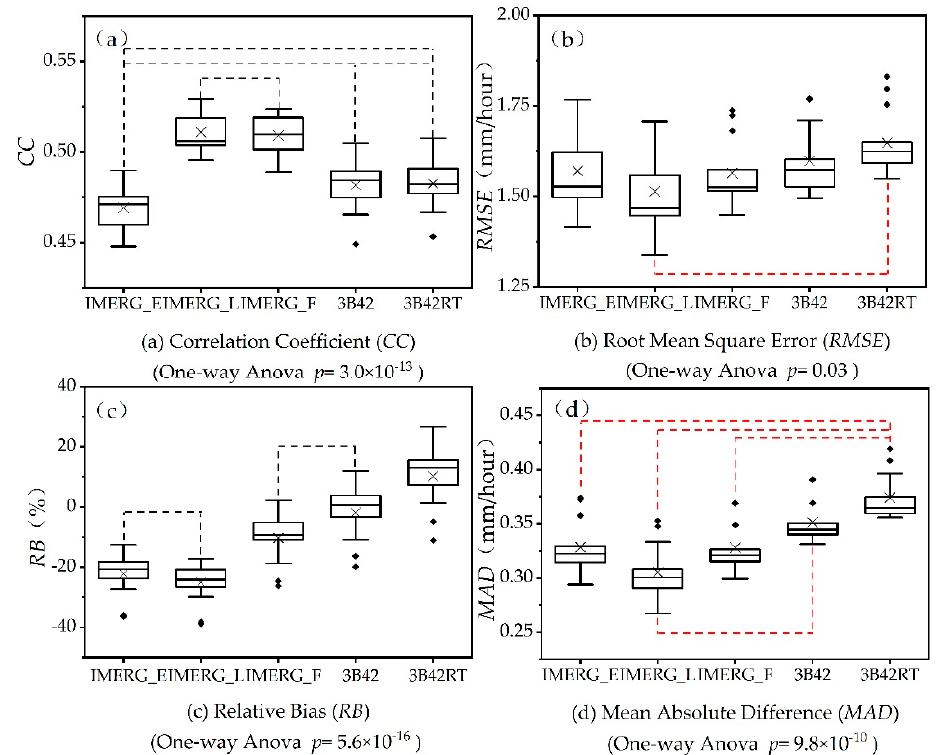
Figure 8. Boxplots of the four continuous evaluation metrics (April to October) of SPPs at hourly scale: ( a ) correlation coe ffi cient ( CC ) (Levene’s test, p = 0.77; one-way ANOVA, p = 3.0 × 10 − 13 ); ( b ) root-mean-square error (RMSE) (Levene’s test, p = 0.63; one-way ANOVA, p = 0.03); ( c ) relative